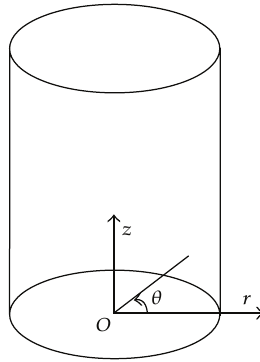
Figure 1: The coordinate system of the circular cylinder.